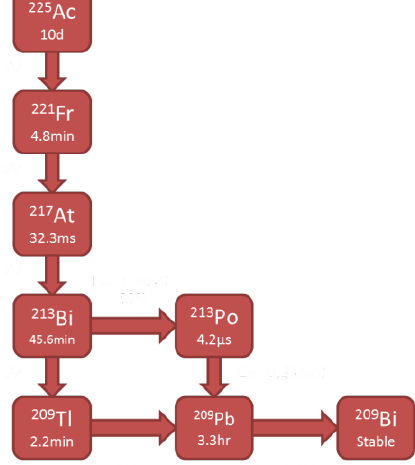
Figure 1. Decay chain of Actinium-225 ( 225 Ac).